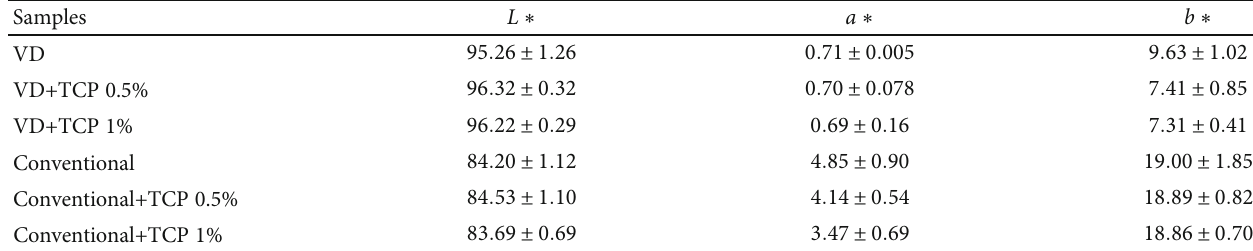
Table 4: Colour analysis with the addition of